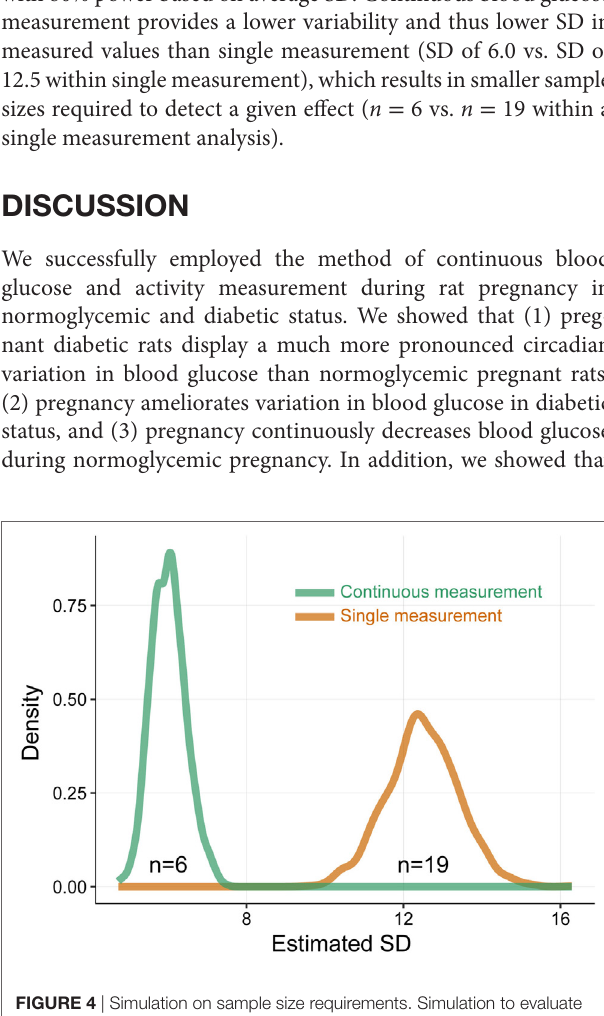
Figure 3 ) nor in normoglycemic Tet29 rats ( p = 0.084; Figure 3